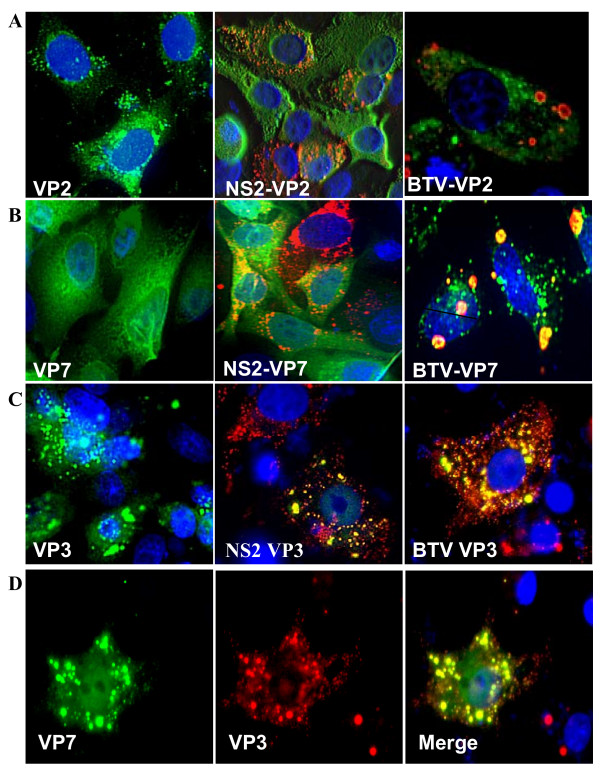
Sub-cellular localization of BTV VP2, VP7 and VP3 in NS2 expressing or BTV infected BSR cells. (A) Distribution of VP2 (green) and NS2 (red) in BSR cells transfected with plasmids expressing VP2 and NS2 (middle) or infected with BTV-10 (right). (B) Localization of VP7 (green) and NS2 (red) in transfected (middle) and infected cells (right). (C) Expression of VP3 (green) and NS2 (red) in transfected (middle) and infected cells (right). (D) Co-localization of VP7 (green) and VP3 (red) in full-length NS2 expressing BSR cells co-transfected with plasmids expressing VP7 and VP3. BSR cells transfected with VP2, VP7 and VP3 were used as controls (left column in A, B and C).